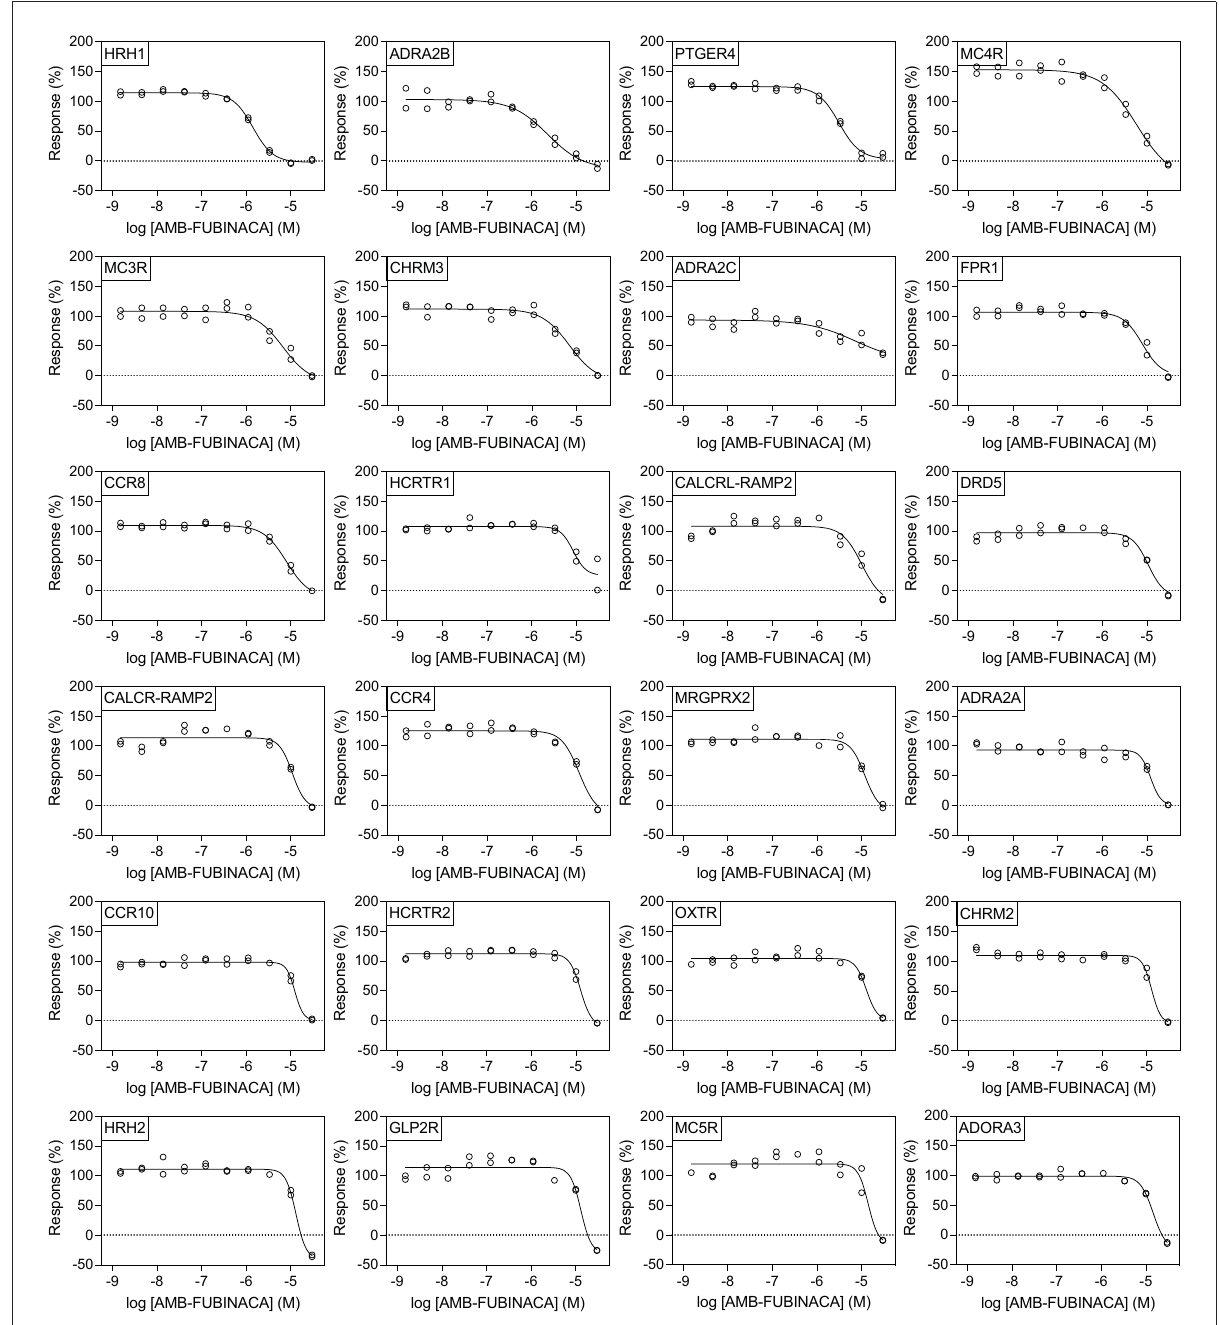
FIGURE4 Effect of AMB-FUBINACA in β -arrestin recruitment across 24 GPCRs. Inhibition of AMB-FUBINACA is shown with increasing concentration as well as the best fit curve against EC 80 of the control ligand at each target (indicated in top left of panel, sorted in order of potency). Control agonists and the respective EC 80 concentrations used for screening are included as Supplementary Table